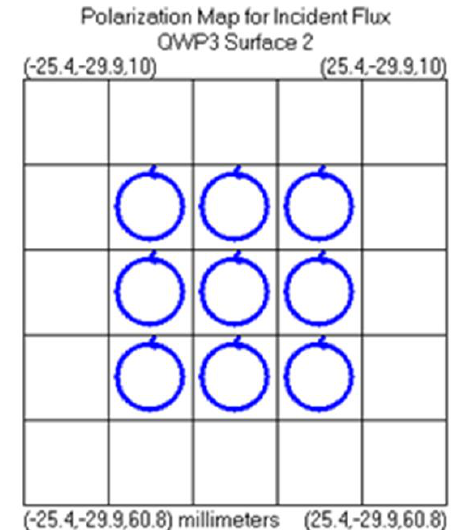
Figure 5. The polarization state of the light wave emitted from arm 2 after passing through QWP